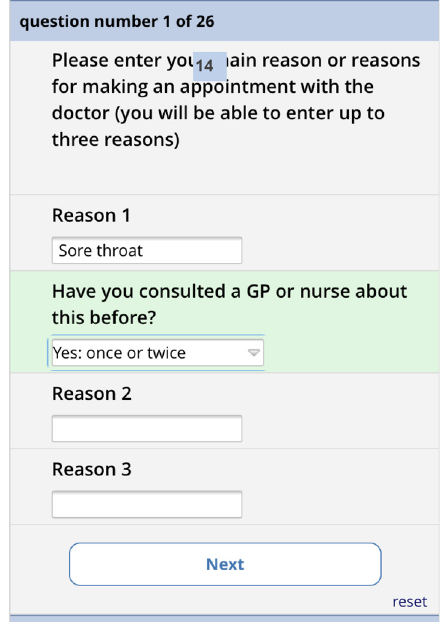
Figure 11. Pre-consultation form: Reasons for consultation screen.